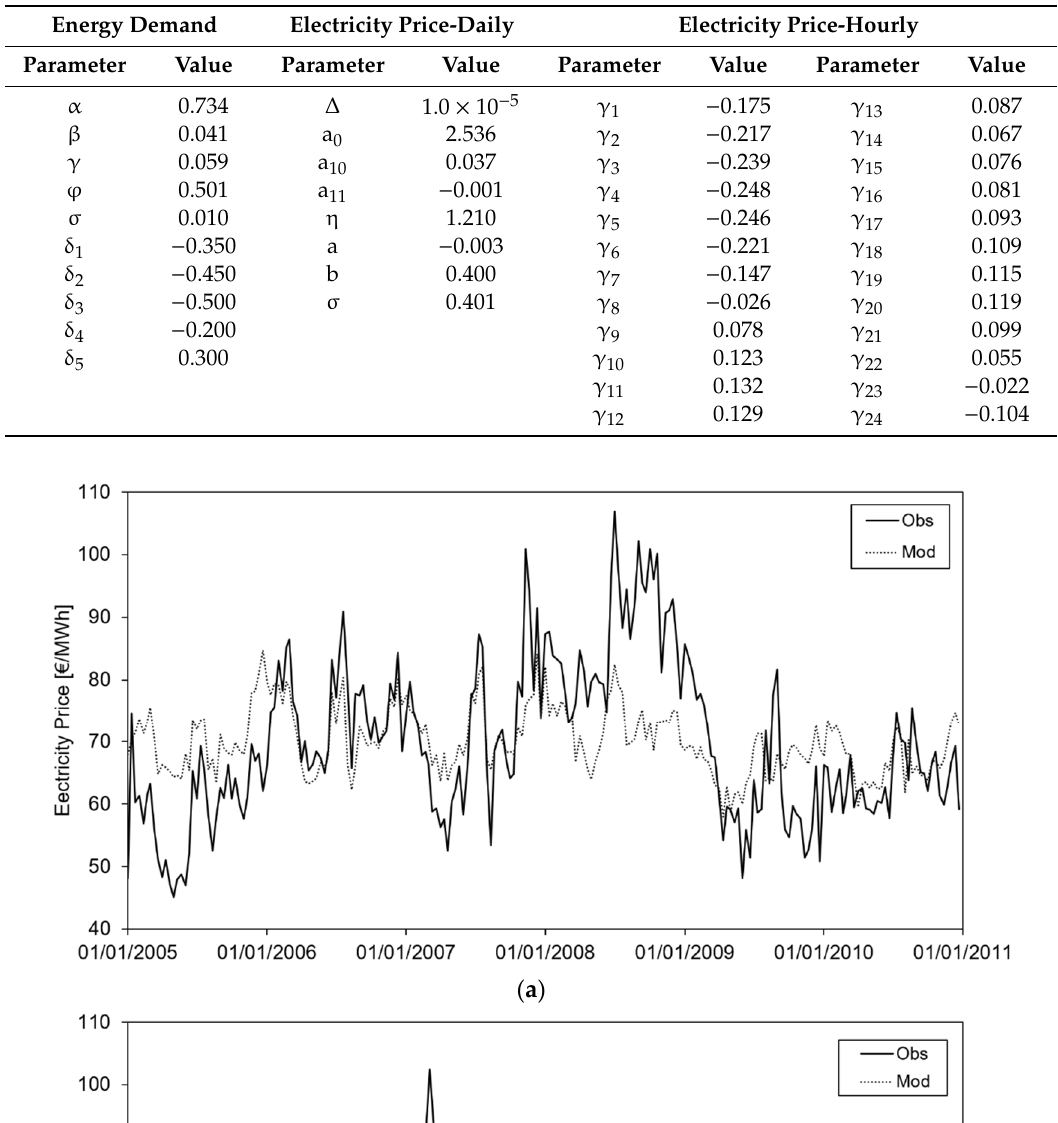
Table 2. Model parameters.